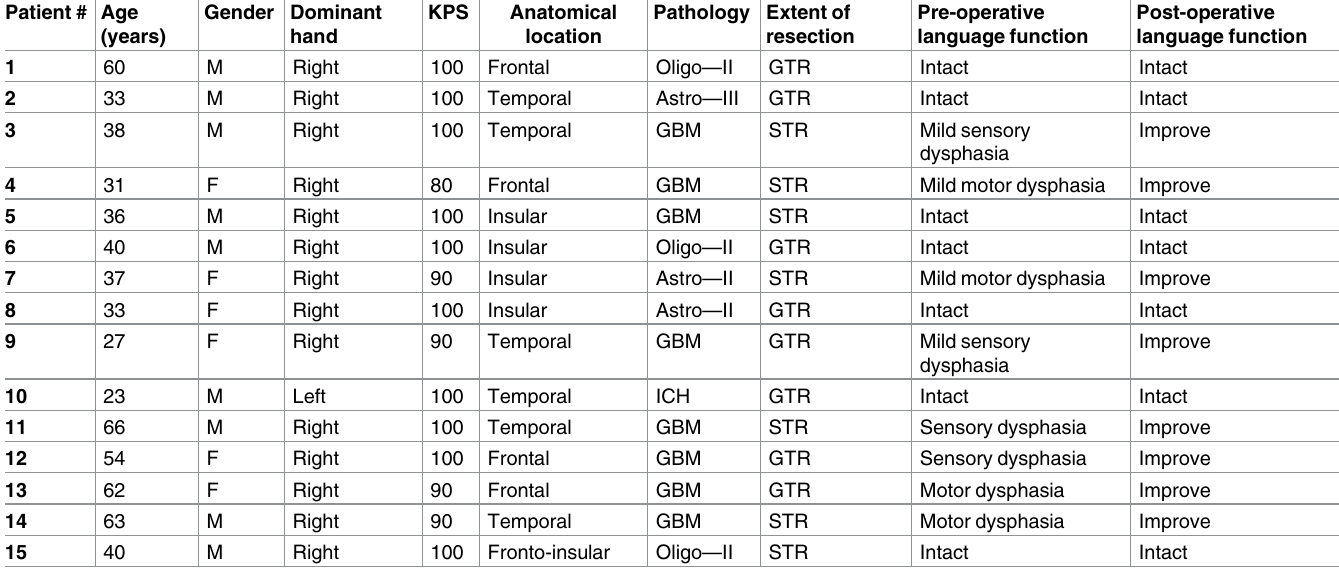
Table 1. Clinical and demographic